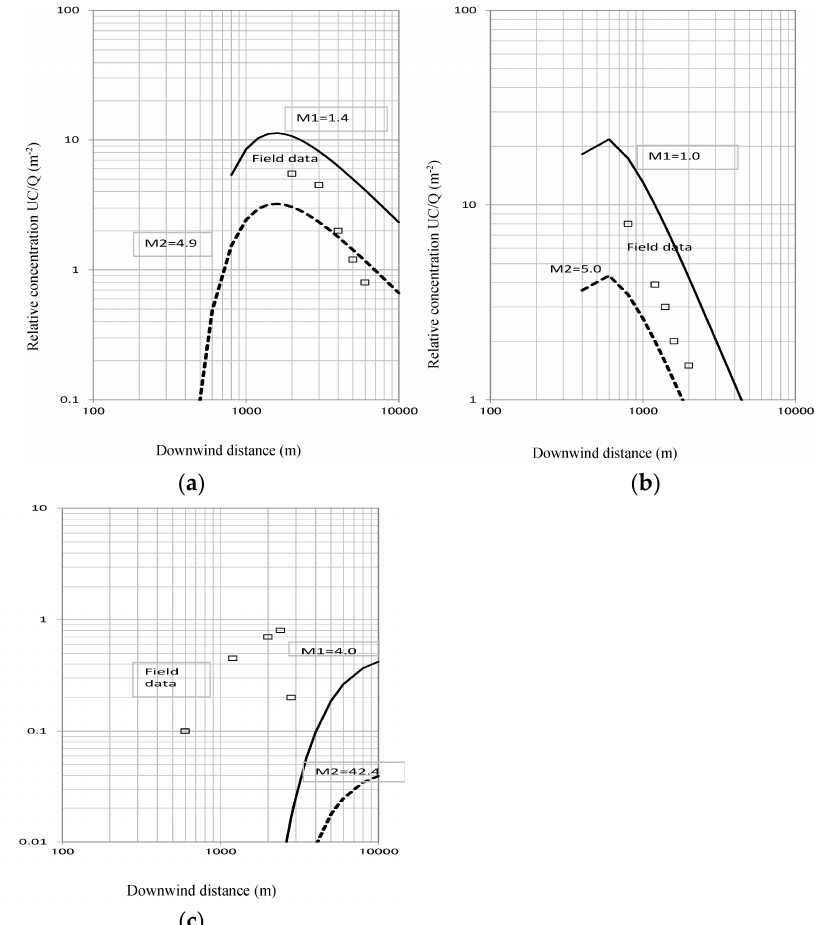
Figure 12. Comparison of the field data with the model predictions, based on the effective stack height, and including corrections for meandering (i.e., using M1 , solid line, or M2 , dashed line). ( a ) Run No. 89-3 (D); ( b ) Run No. 90-8 (B); ( c ) Run No. 90-5 (F).